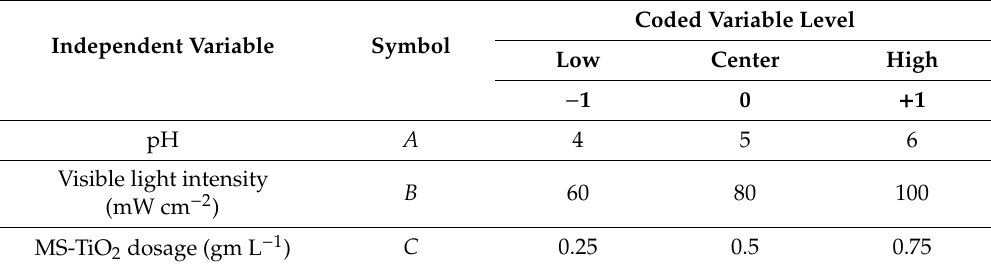
Table 6. The levels and ranges of variables in statistical experimental